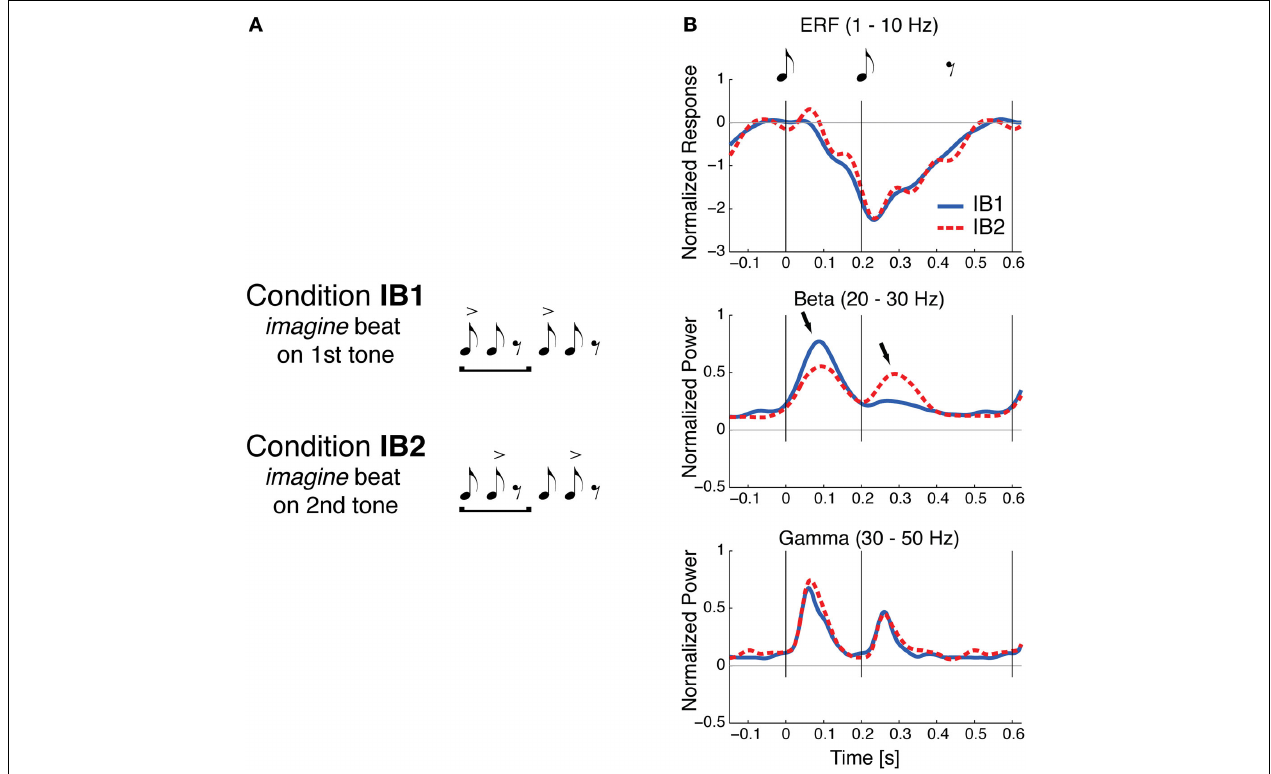
FIGURE 2 | Sound evoked responses are modulated by beat perception, from Iversen et al. (2009). (A) Illustration of two conditions in the study of Iversen et al. (2009). A simple two-note repeating pattern is heard by listeners. On some trials listeners imagine the beat is on the first tone (condition IB1); on other trials, they imagine the beat is on the 2nd tone (condition IB2). The accents indicate the imagined beat and do not correspond to any physical differences in the stimulus, which were identical in the two conditions. (B) Normalized evoked neural responses for the two imagined beat conditions, measured with MEG. Thin gray vertical lines at 0 and 200ms indicate onset of the two tones (each 45ms long and 1KHz in